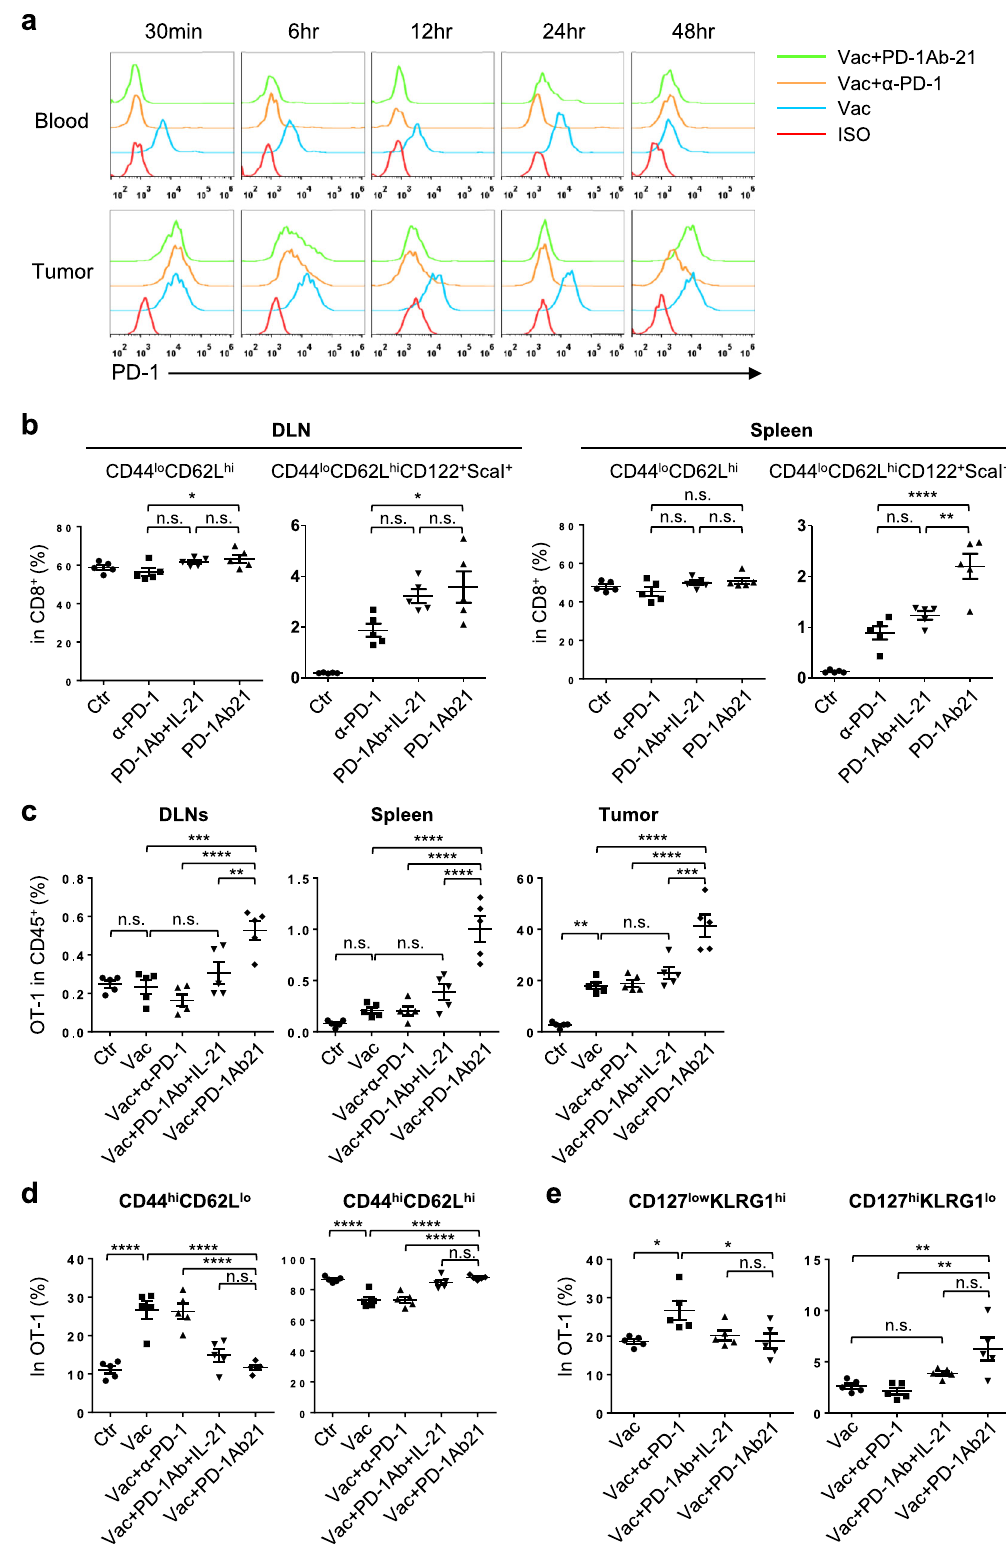
vaccination, whereas PD-1Ab21 treatment generated resident self-renewing memory T cells in DLNs. This is further supported by the phenotypes of OT-1 cells in DLNs. The frequencies of CD44 high CD62L low cells in the OT-1 cells were much higher in mice treated with vaccination alone or combination with anti- PD-1 antibody than in mice treated with PD-1Ab21. The